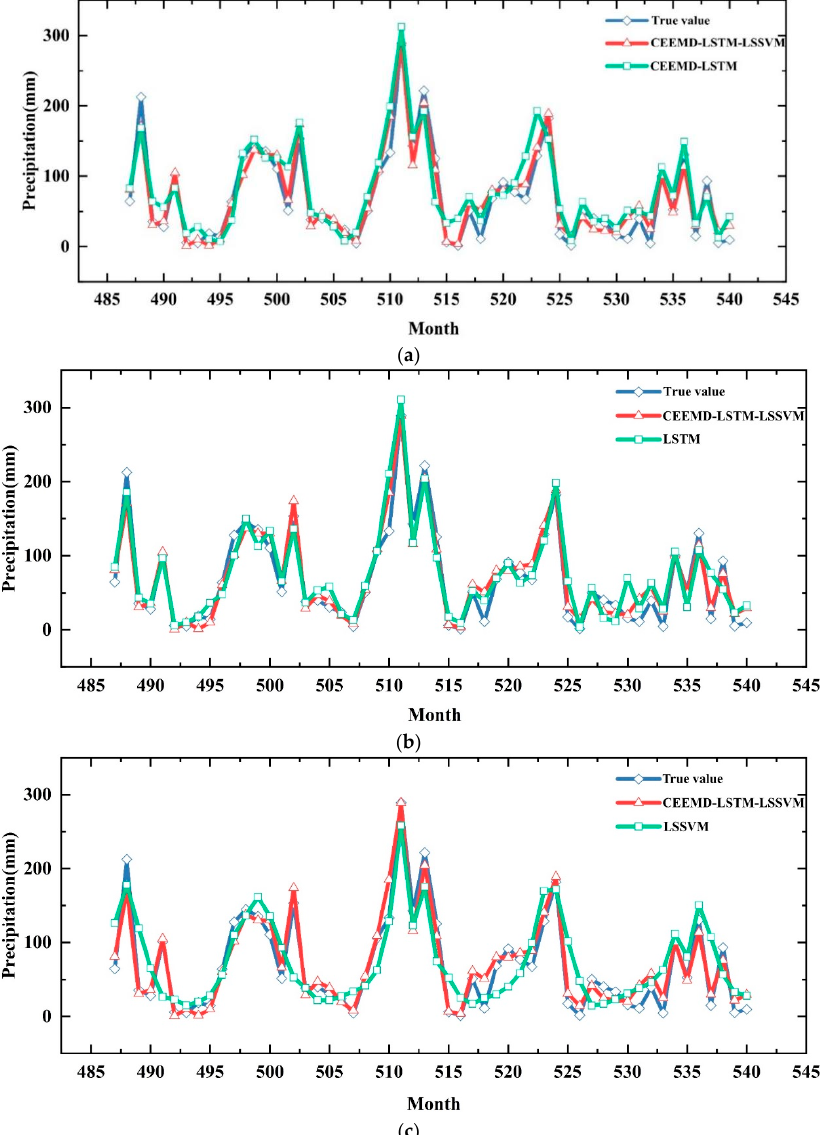
Figure 10. Comparison of prediction results of the CEEMD-LSTM-LSSVM model with those of other models. ( a ) Prediction results of CEEMD-LSTM-LSSVM compared with CEEMD-LSTM. ( b ) Compari- son of prediction results of CEEMD-LSTM-LSSVM with LSTM. ( c ) Comparison of prediction results of CEEMD-LSTM-LSSVM and